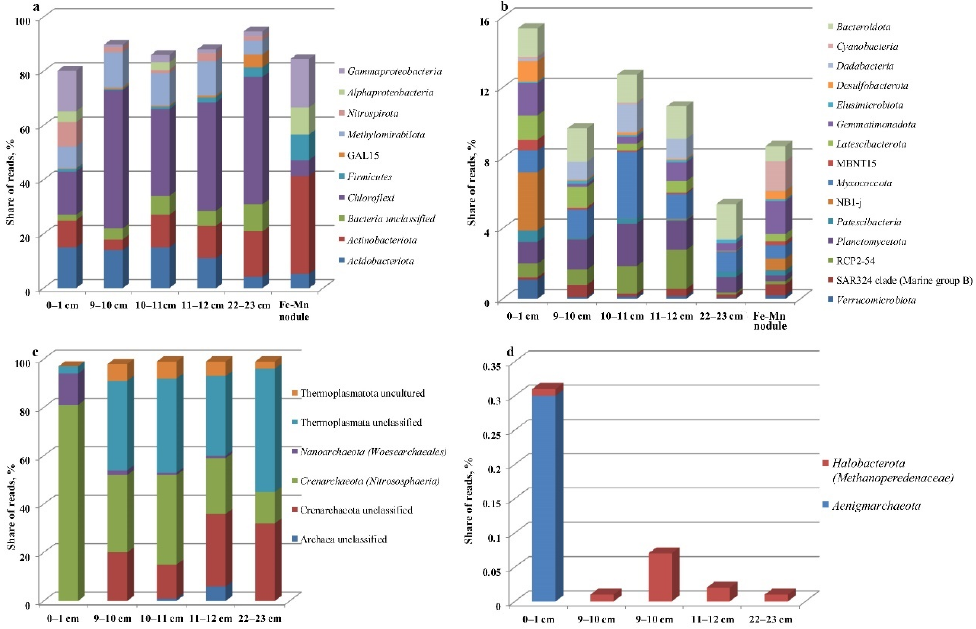
Figure 6. Taxonomic composition ( a , b ) of the bacterial and ( c , d ) archaeal communities in the bottom sediments near Bolshoy Ushkany Island, as well as in the Fe-Mn nodule at the phylum level; a,c — more than 97% of reads; ( b , d )—less than 3% of reads. The microbial community of the Fe-Mn nodule had a lower number of dominant phyla and a wide range of OTUs with a small number of sequences of different taxa (Fig- ure 6a,b). The dominant phyla include Actinobacteriota (36.2%), Firmicutes (9.5%), Chlor- oflexi (5.8%), Acidobacteriota (5.3%), and classes Alpha- and Gammaproteobacteria (10 and 17.8%, respectively). Sequences of the phyla Methylomirabilota and Nitrospir о ta occurred in small amounts. The wide range of OTUs in the 16S rRNA gene library of the Fe-Mn nodule had a minor component of the community (less than 3% of reads of all bacterial 16S rRNA sequences; Figure 6b). They were most similar to those involved in the destruction of substrates under aerobic and anaerobic conditions from different eco- topes, such as anaerobic chemoheterotrophic members of the candidate phylum Acetother- to acetate, formate and hydrogen [80]; anaerobic Dehalococcoidia (FS117-23B-02_ge, GIF9, MSBL5) that use halogenated compounds as electron acceptors [81] and occur in the com- munities of the sediments and deep water in the southern basin of Lake Baikal (personal data) [82]; and microarophillic Ca. Methylospira involved in methane oxidation, and oth- ers. The comparison of beta diversity based on the Bray–Curtis distance matrix displayed the heterogeneity of the structure of bacterial communities at different depths of sedi- ments and in comparison with Fe-Mn nodule (Figure 6a,b). The structure of the bacterial community in sample 22–23 cm differed from the others by the dominance of members of Chloroflexi , GAL15, Firmicutes, Actinobacteriota , and unclassified bacteria. Communities from other sediment layers had a more similar composition. They contained Methylomira- bilota members and different contribution of dominant members of Chloroflexi , Acidobacte- riota and Actinobacteriota . Contribution to the bacteria of the phylum Methylomirabilota involved in the methane cycle is a varied. The number of sequences of this phylum in the communities of Fe-Mn nodules was less (2.4%) than in the communities of Fe-Mn layers (12–13%) and in sedi- mentary layers 0–1 cm and 22–23 cm (8.7% and 5.2%, respectively). Some order